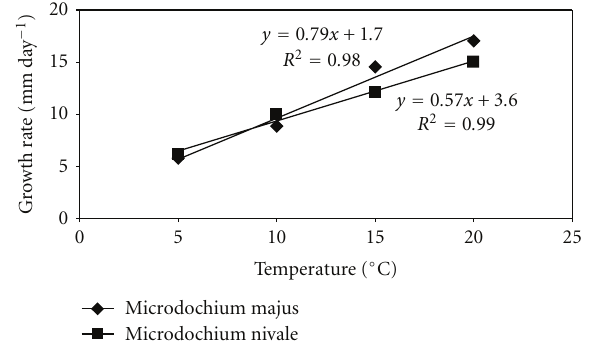
Figure 1: In vitro growth of 5 Microdochium majus and 5 Microdochium nivale isolates on winter wheat cv. Equinox flour agar.